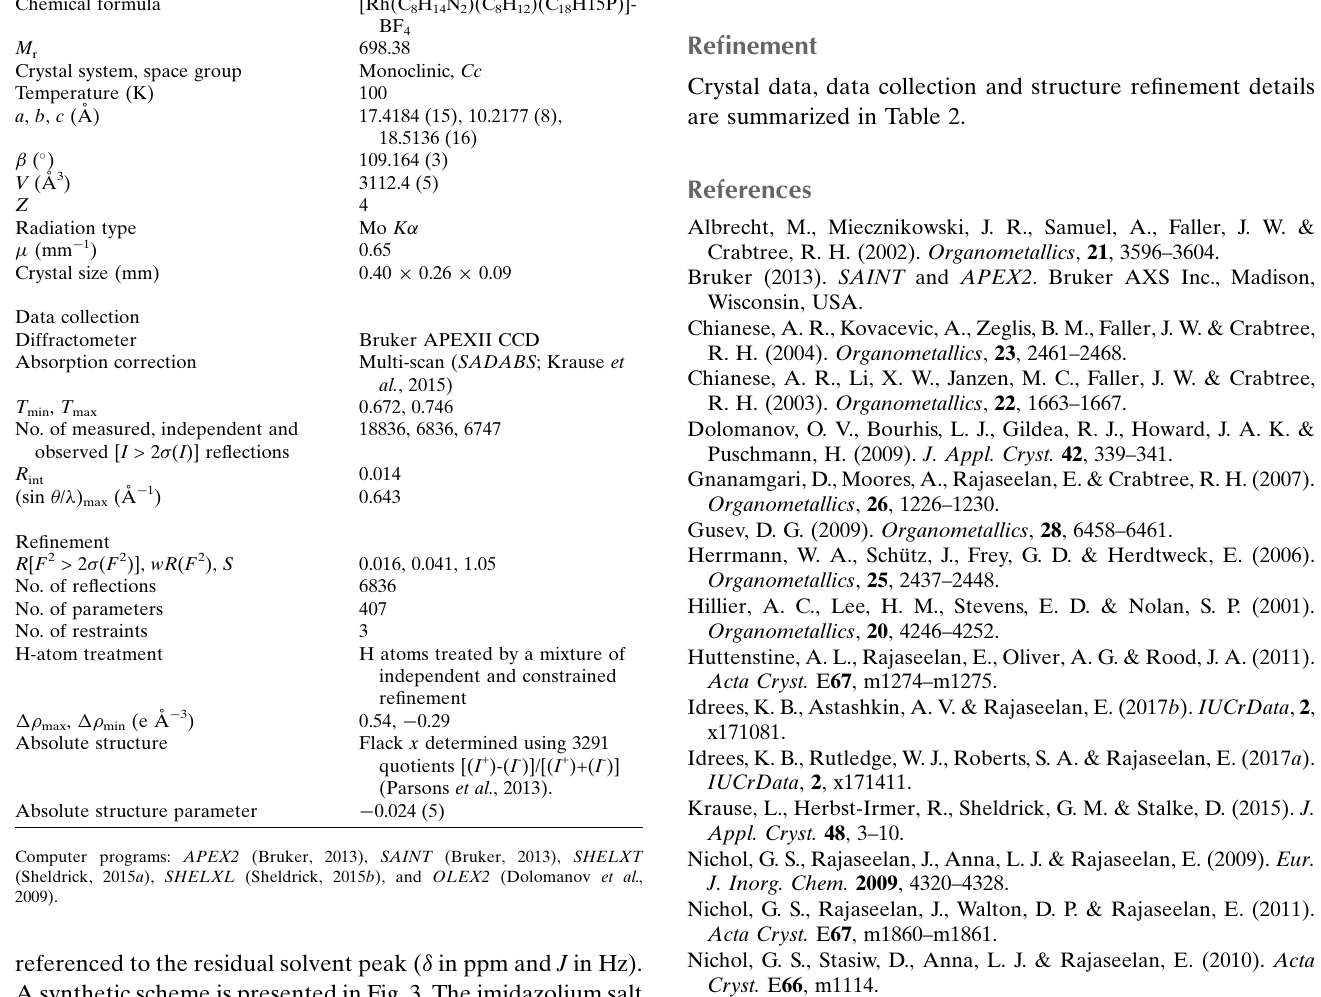
Table 2 Experimental details. Crystal data Chemical